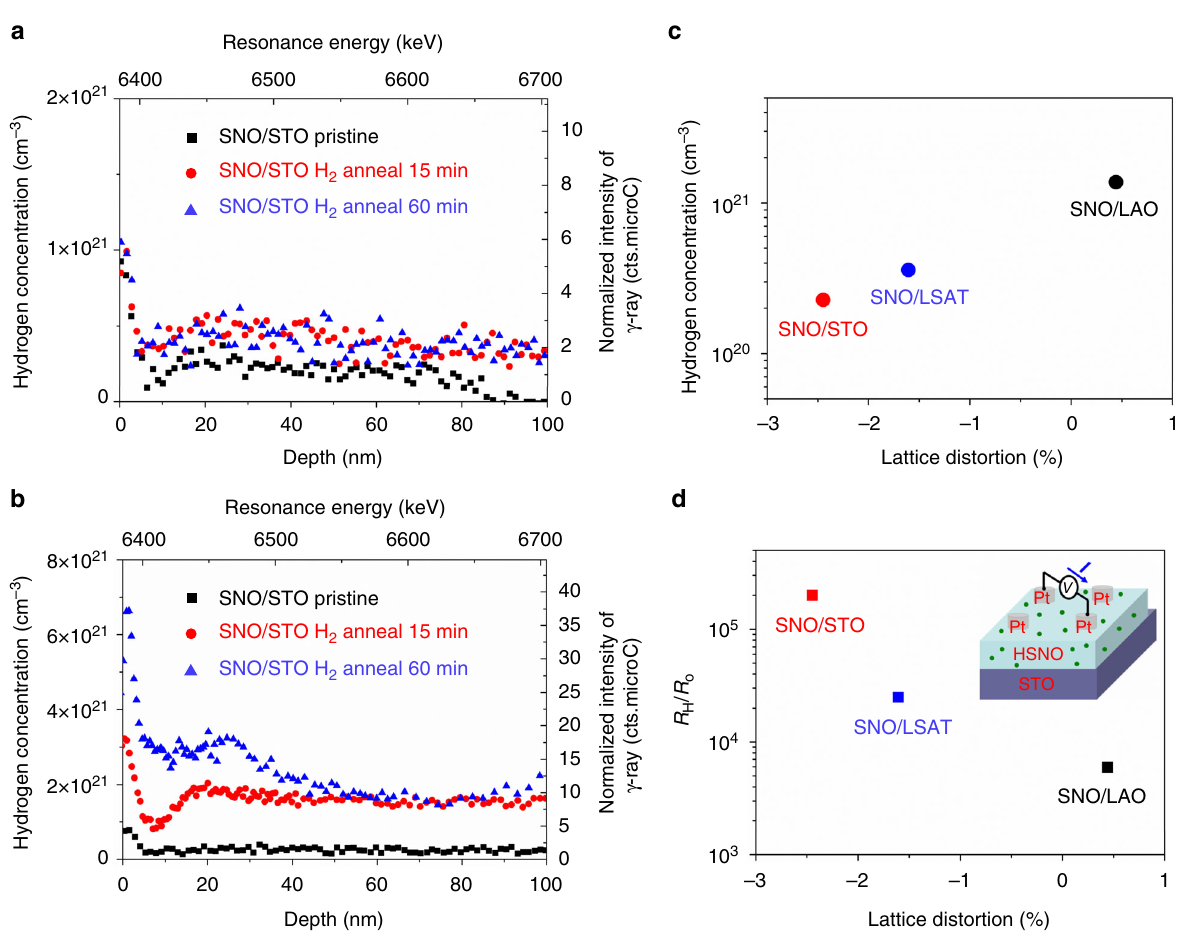
Fig. 3 Hydrogen pro fi les and resistivity of H x SmNiO 3 upon distortions. a, b Hydrogen depth pro fi les for a SmNiO 3 /SrTiO 3 and b SmNiO 3 /LaAlO 3 in the 1% H 2 /He atmosphere after designed annealing durations. Black square: pristine SmNiO 3 ; red dot: upon hydrogen annealing for 15 min; blue triangle: upon hydrogen annealing for 60 min c Hydrogen concentration after annealing for 15 min and d the respective enhancements of the resistivity, plotted as a function of the lattice distortions for SmNiO 3 grown on different single crystal substrates of SrTiO 3 (red), (La,Sr)(Al,Ta)O 3 (blue), and LaAlO 3